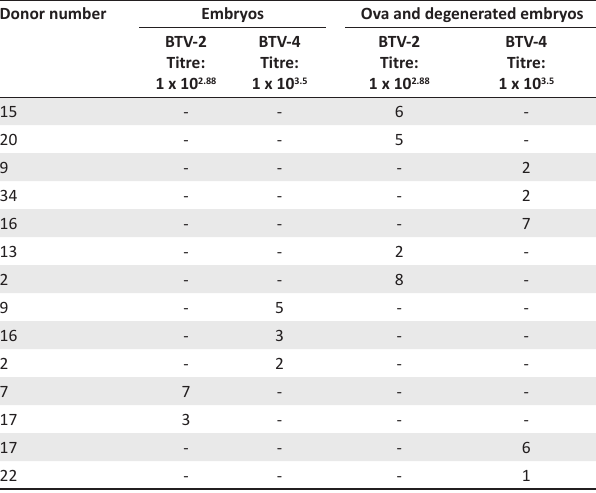
TABLE 2: The number of embryos, ova and degenerated embryos infected with different titres of BTV (Experiment 1). Donor number